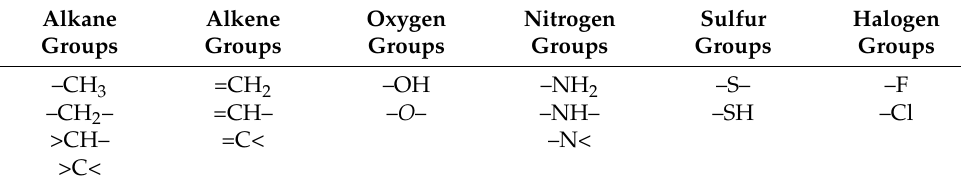
Table 1. Considered functional groups for the search of refrigerant molecules. Alkane Groups